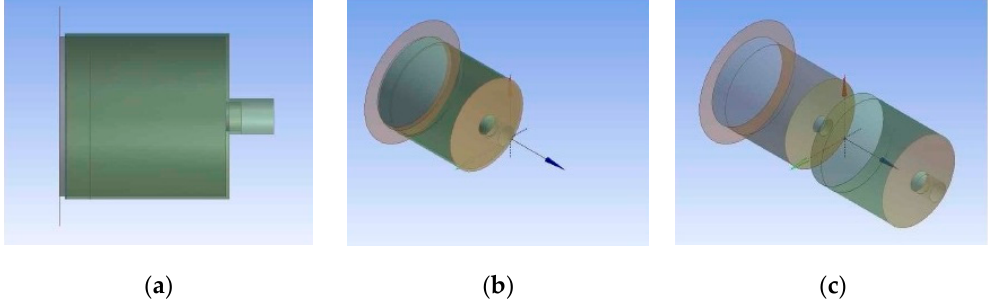
Figure 15. Magnet coupler three-dimensional (3D) models of the bulkhead and outer rotor. ( a ) Side view of the bulkhead and outer rotor together, ( b ) an isometric view of the bulkhead and outer rotor, ( c ) the exploded view of bulkhead and outer rotor. Table 3. Number of Nodes and Elements for the Bulkhead and Outer Rotor.